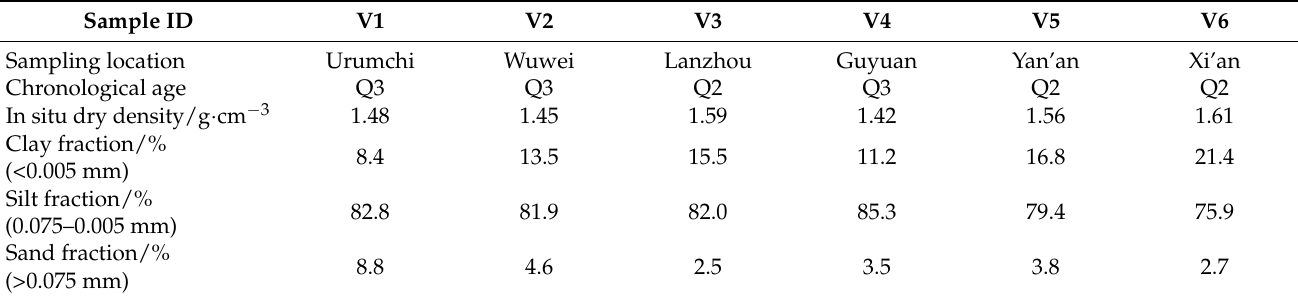
Figure 11. Sampling locations of six types of loess used for validating the WGCC model. Table 4. Basic information of loess samples used for model validation.